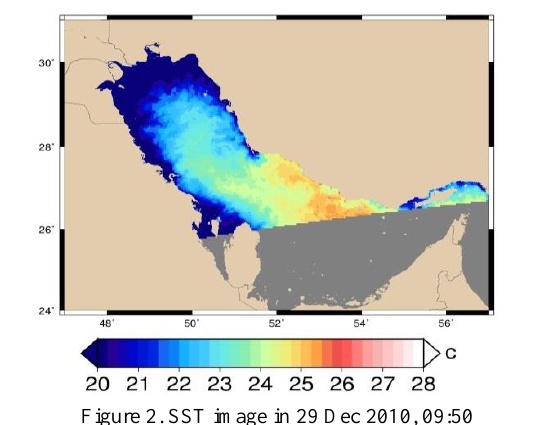
Figure 2. SST image in 29 Dec 2010, 09:50